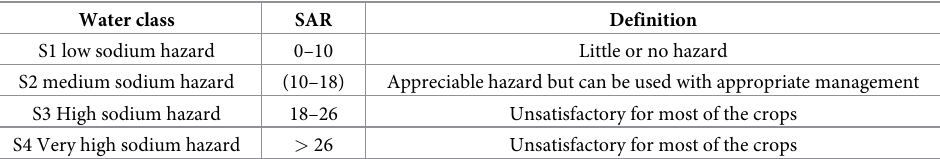
Table 5. Sodium hazard zones: Based on sodium adsorption ratio